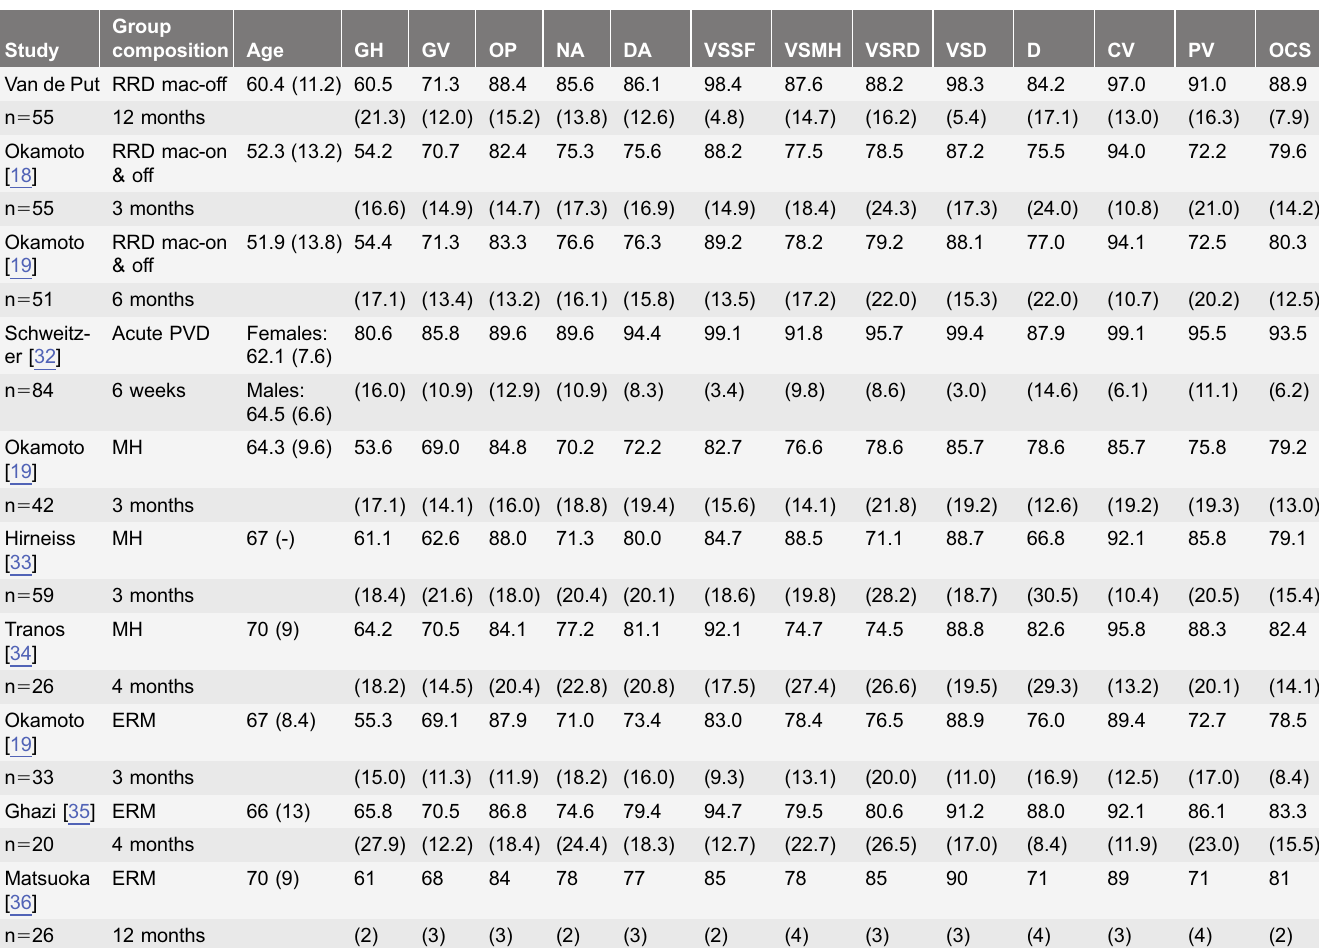
Table 5. NEI VFQ-25 overall composite score and subscale scores for the present study and previously published studies, mean (SD).